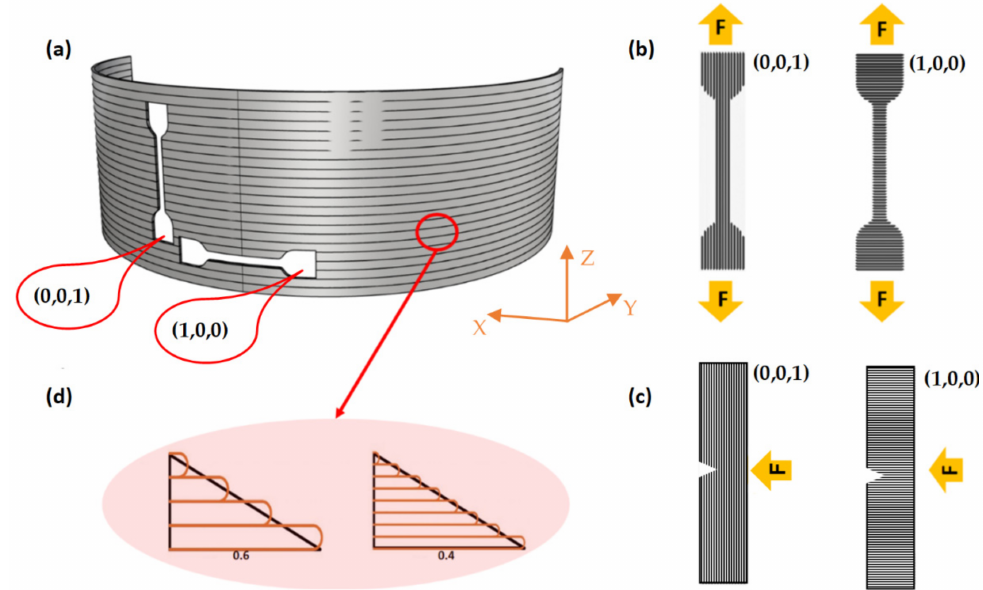
Figure 2. ( a ) Schematic representation of the test specimens cut from hemi-cylinder; filament orienta- tion for ( b ) tensile and ( c ) Charpy impact test; ( d ) layer thickness considerations for the realisation of the